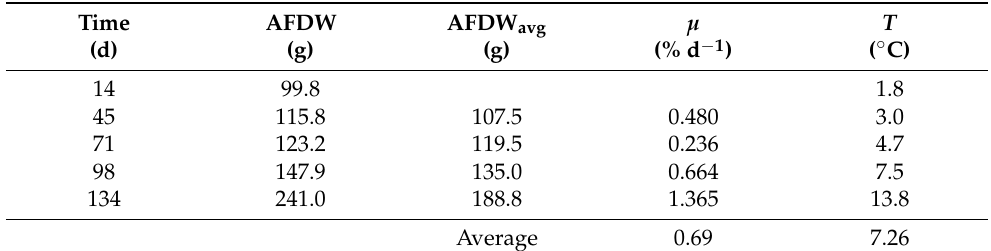
Table A2. Halichondria panicea. Development of sponge biomass (AFDW) and temperature obtained by replotting data from [34] based on a field experiment at Boknis Eck, Western Baltic Sea, at 10 m and used here for calculation of the weight-specific growth rate ( µ ).